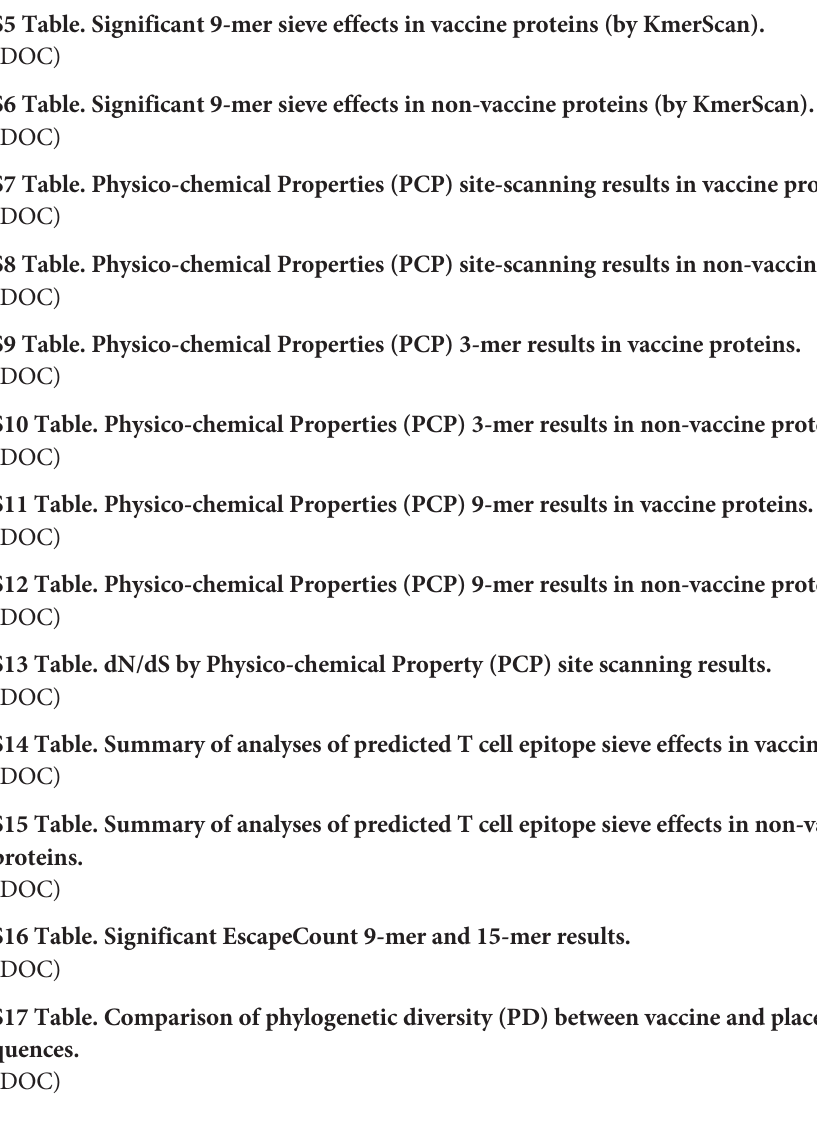
S17 Table. Comparison of phylogenetic diversity (PD) between vaccine and placebo se-